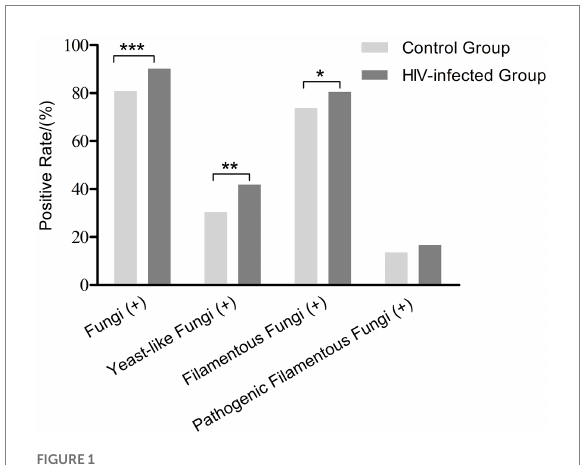
FIGURE 1 Positive rates of fungal carriage in the HIV-infected group and the control group. * p < 0.05, ** p < 0.01, *** p < 0.001.